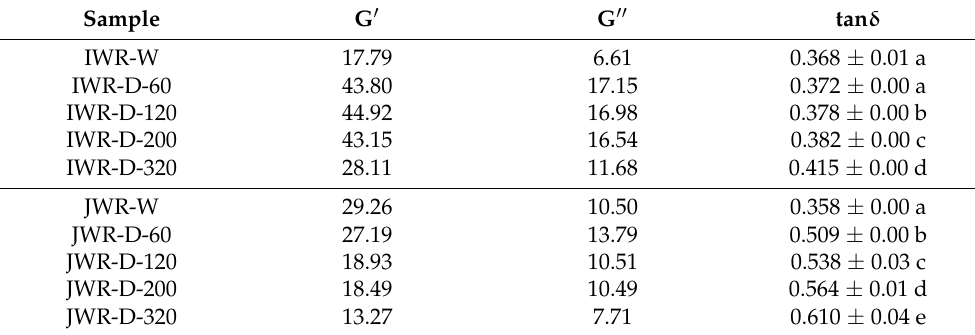
Table 2. Fitting parameters of viscoelastic properties of waxy rice